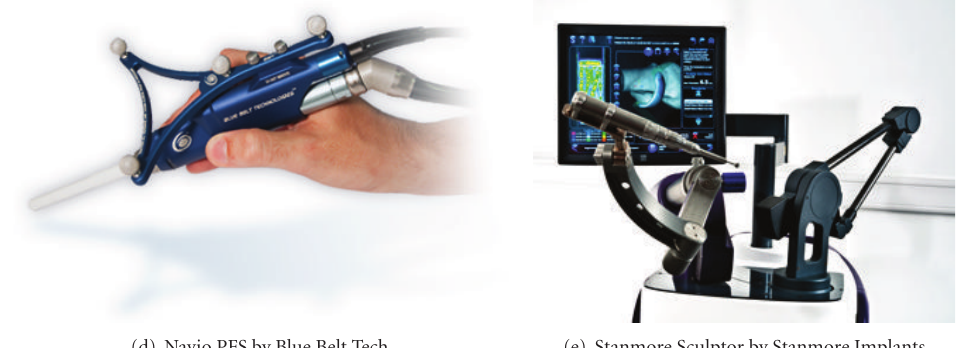
Figure 2: Orthopedic robots for accurate bone resection. The Robodoc image is ©2012 Curexo Technology Corp. The RIO image is ©2012 MAKO Surgical Corp. The iBlock image is ©2012 Praxim Inc. The Navio PFS image is ©2012 Blue Belt Tech. The Stanmore Sculptor image is ©2012 Stanmore